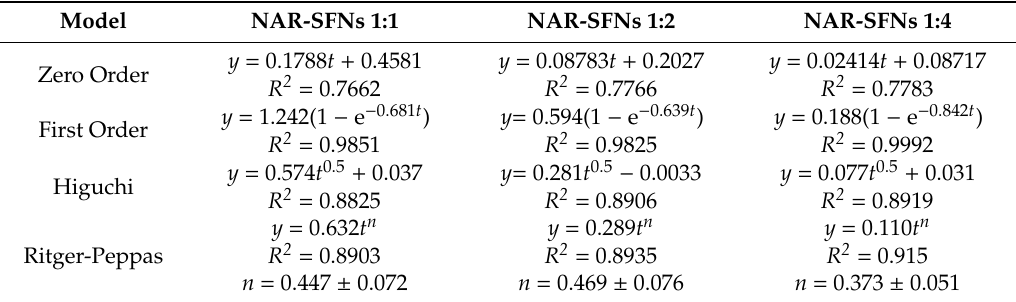
Table 3. Release models of